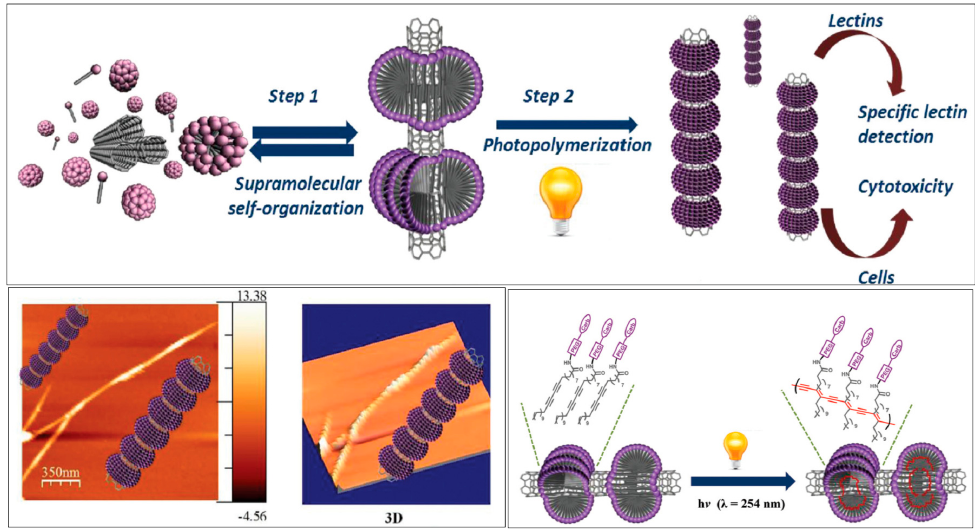
Figure 4. Synthesis and applications of hierarchically self-assembled and photopolymerized neoglycolipids onto SWCNT sidewalls ( upper ). SEM and TEM images of SWCNTs modified by glycolipids forming nanorings ( lower left ) and polymerization of the glyconanoring-coated carbon nanotubes ( lower right ). Reproduced with permission from [54]. Copyright Royal Society of Chemistry, 2015.